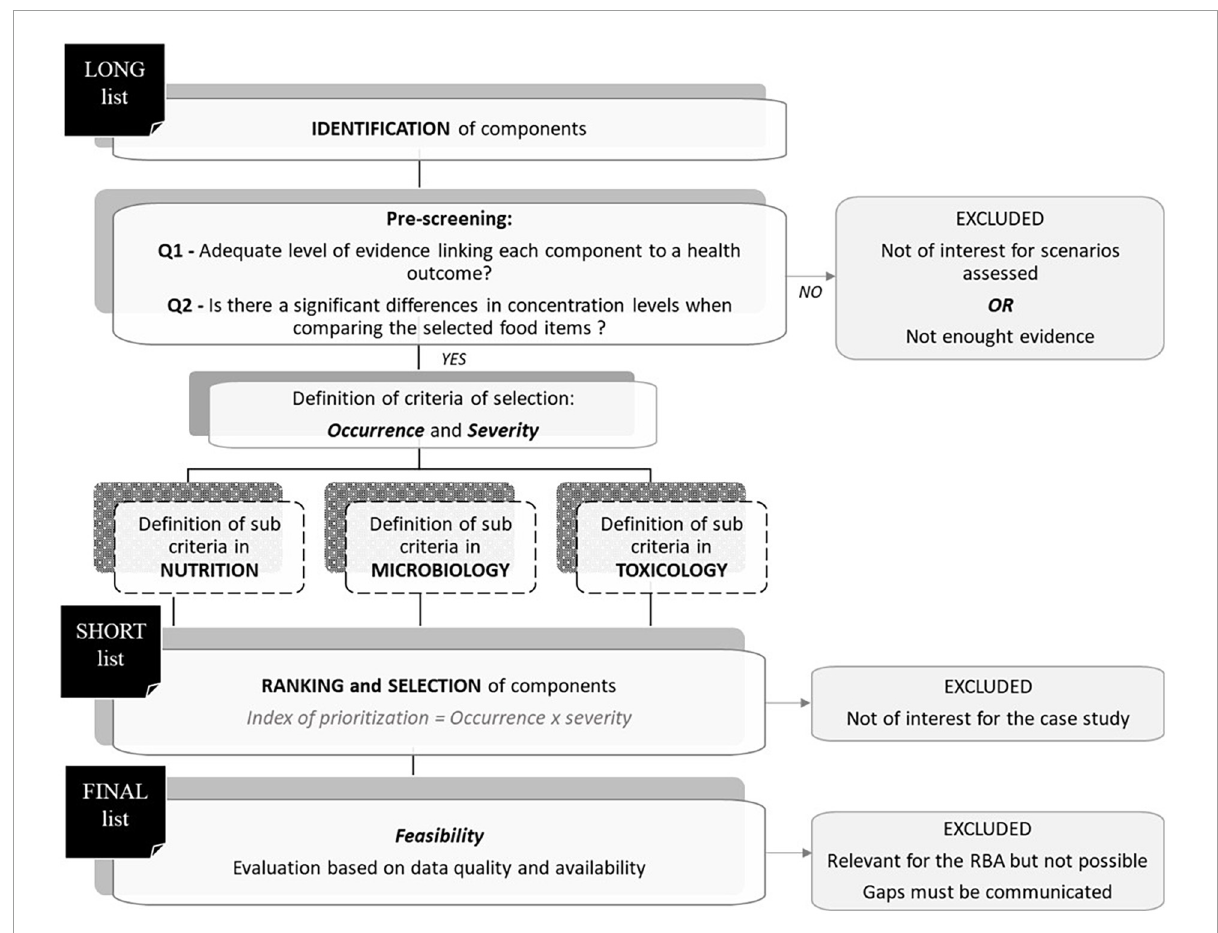
FIGURE3 Flowchart of the standardized process to select food components (nutrients, microbiological, and chemical hazards) to be consider in the RBA.